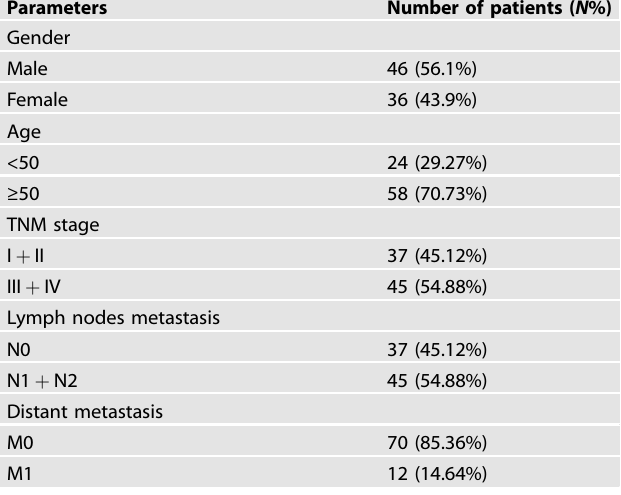
Table 1. The clinicopathological parameters of 82 CRC